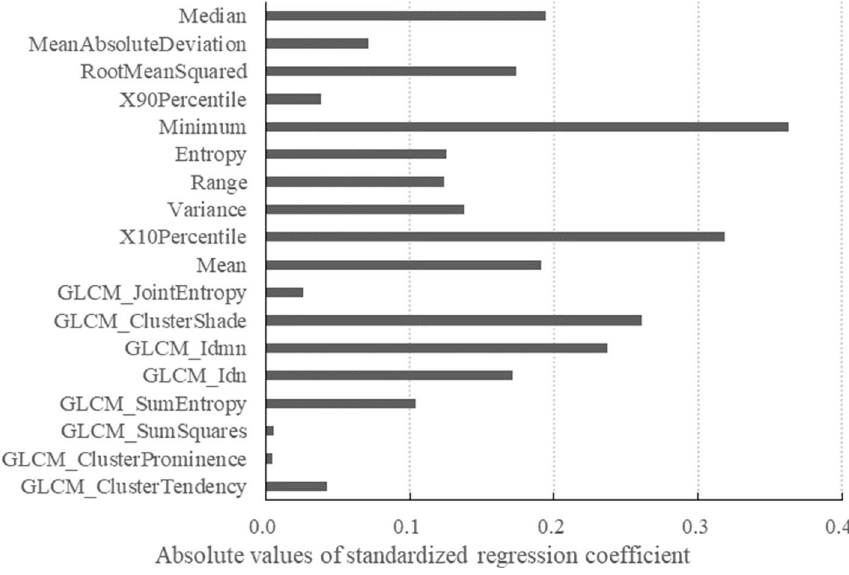
Figure 3. In multivariate analysis, texture features contributed to differentiation between ONB and SCC weighted by absolute values of standardized regression coefficients according to the elastic net logistic regression.